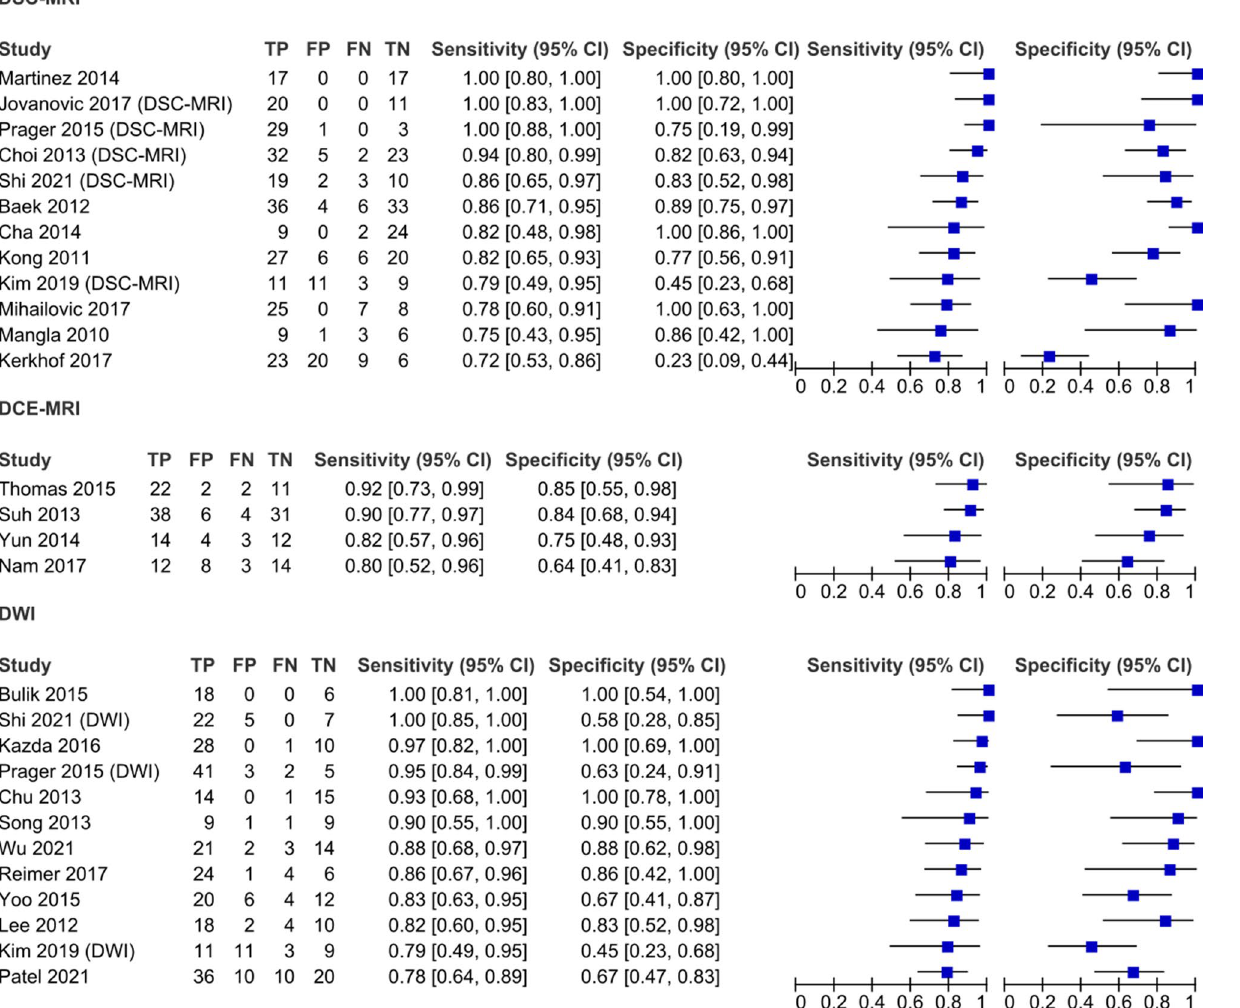
Figure 3. Forest plot subgroup analysis assessing the diagnostic ability of DSC-MRI, DCE-MRI, and DWI. See Fig. 2 for list of